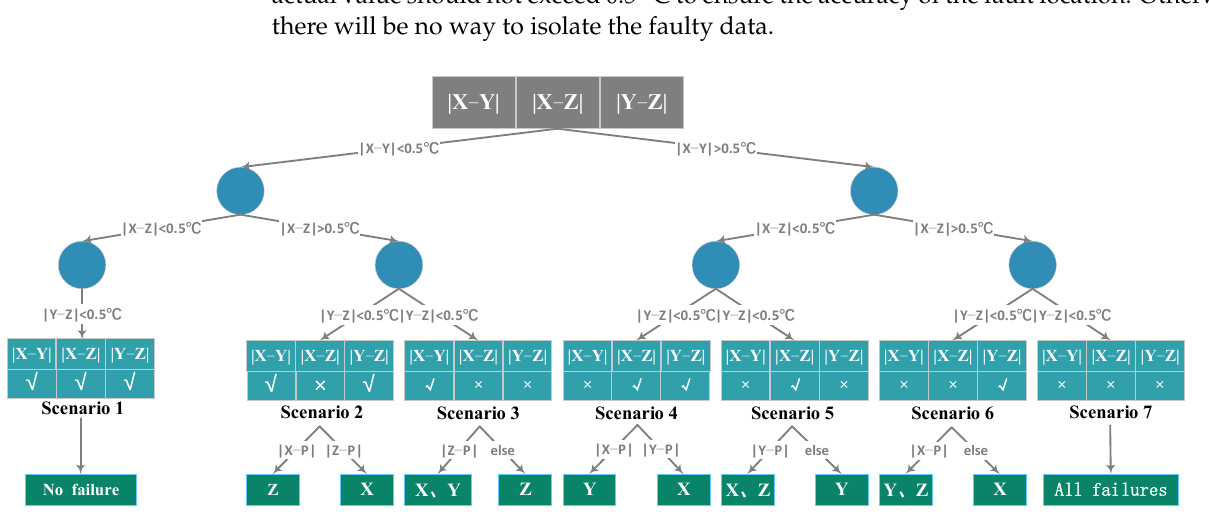
Figure 2. The sensor fault localization decision tree.